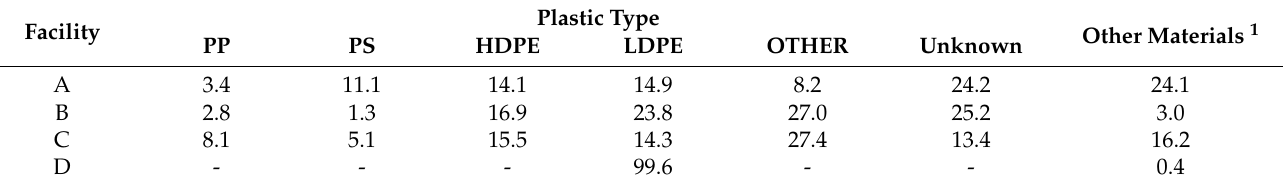
Table 1. Classification of waste feedstock into pyrolyzer (Unit: wt%).